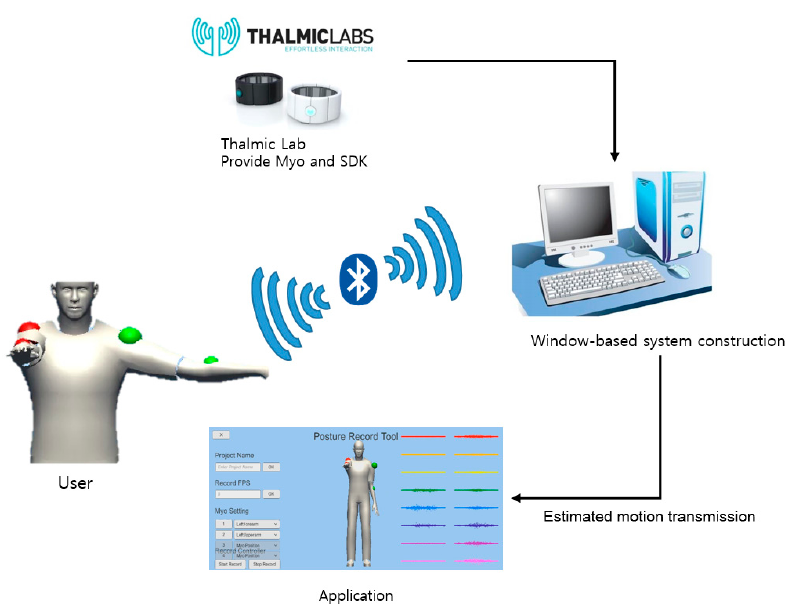
Figure 7. System of Myo device Motion Estimation.